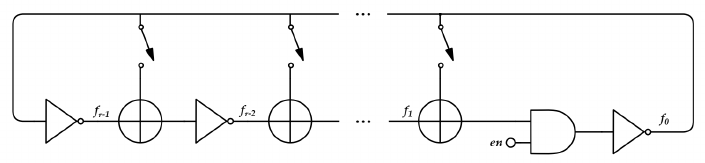
Figure 6. Galois ring oscillator with enable